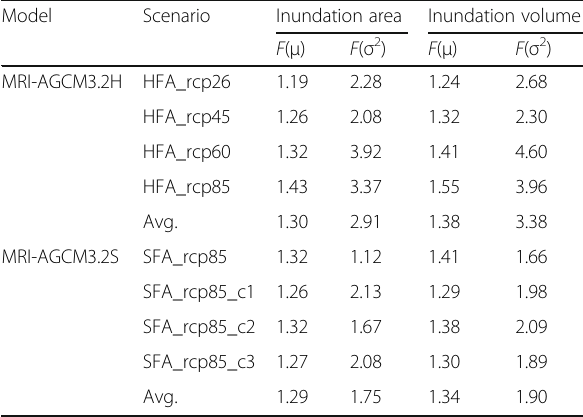
Table 4 The ratio ( F ) of mean ( μ ) and variance ( σ 2 ) of inundation area and volume for future climates comparing their present climate